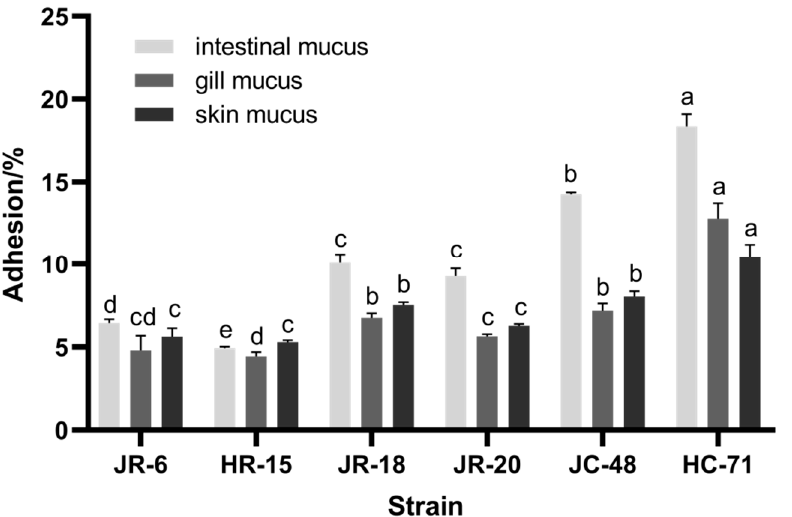
Figure 1. The adhesion rate of six S. putrefaciens strains (JR-6, HR-15, JR-18, JR-20, JC-48, and HC-71) in different mucus. Different lowercase letters indicate significant differences at the 0.05 level ( p < 0.05).